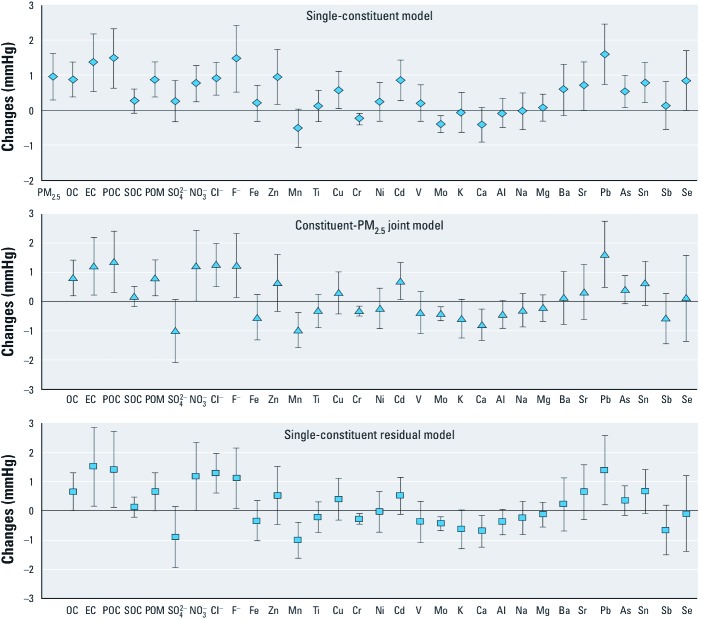
Changes in DBP associated with IQR increases in PM2.5 constituents at concentration during the preceding day before the BP measurement. Estimates are adjusted for age, BMI, season, month, day-of-study, squared day-of-study, day-of-week, hour-of-day, study site, temperature, and relative humidity in linear and quadratic terms. Data are presented as effect estimates ± 95% CIs. For constituent-PM2.5 joint models, we used the main effect estimates of PM2.5 constituents for result presentation.